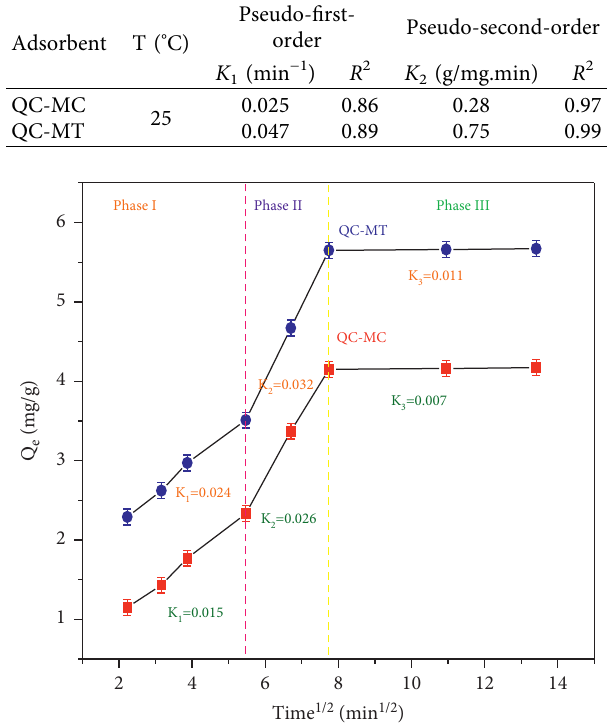
Figure 9: Intraparticle diffusion model of QC-MC and QC-MT ( V � 100mL, T � 25 ° C, C 0 � 10mg/L, m � 1.5g, and pH � 5).